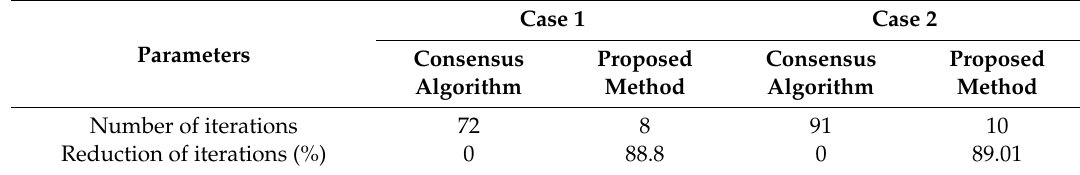
Figure 14. Results for optimal power allocation using consensus algorithm: ( a ) case 1; ( b ) case 2. Table 7. Convergence speed comparison between consensus and proposed method.